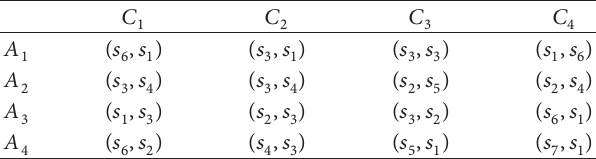
Table 4: The aggregated decision matrix 𝑅 by LIFOWA operator.